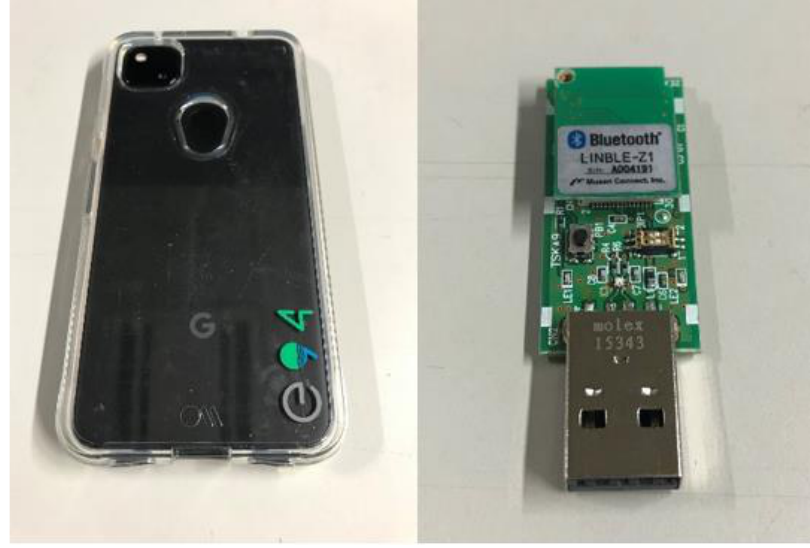
Figure 10. View of T-shaped road, and the setting of Rx movements and Tx positions.